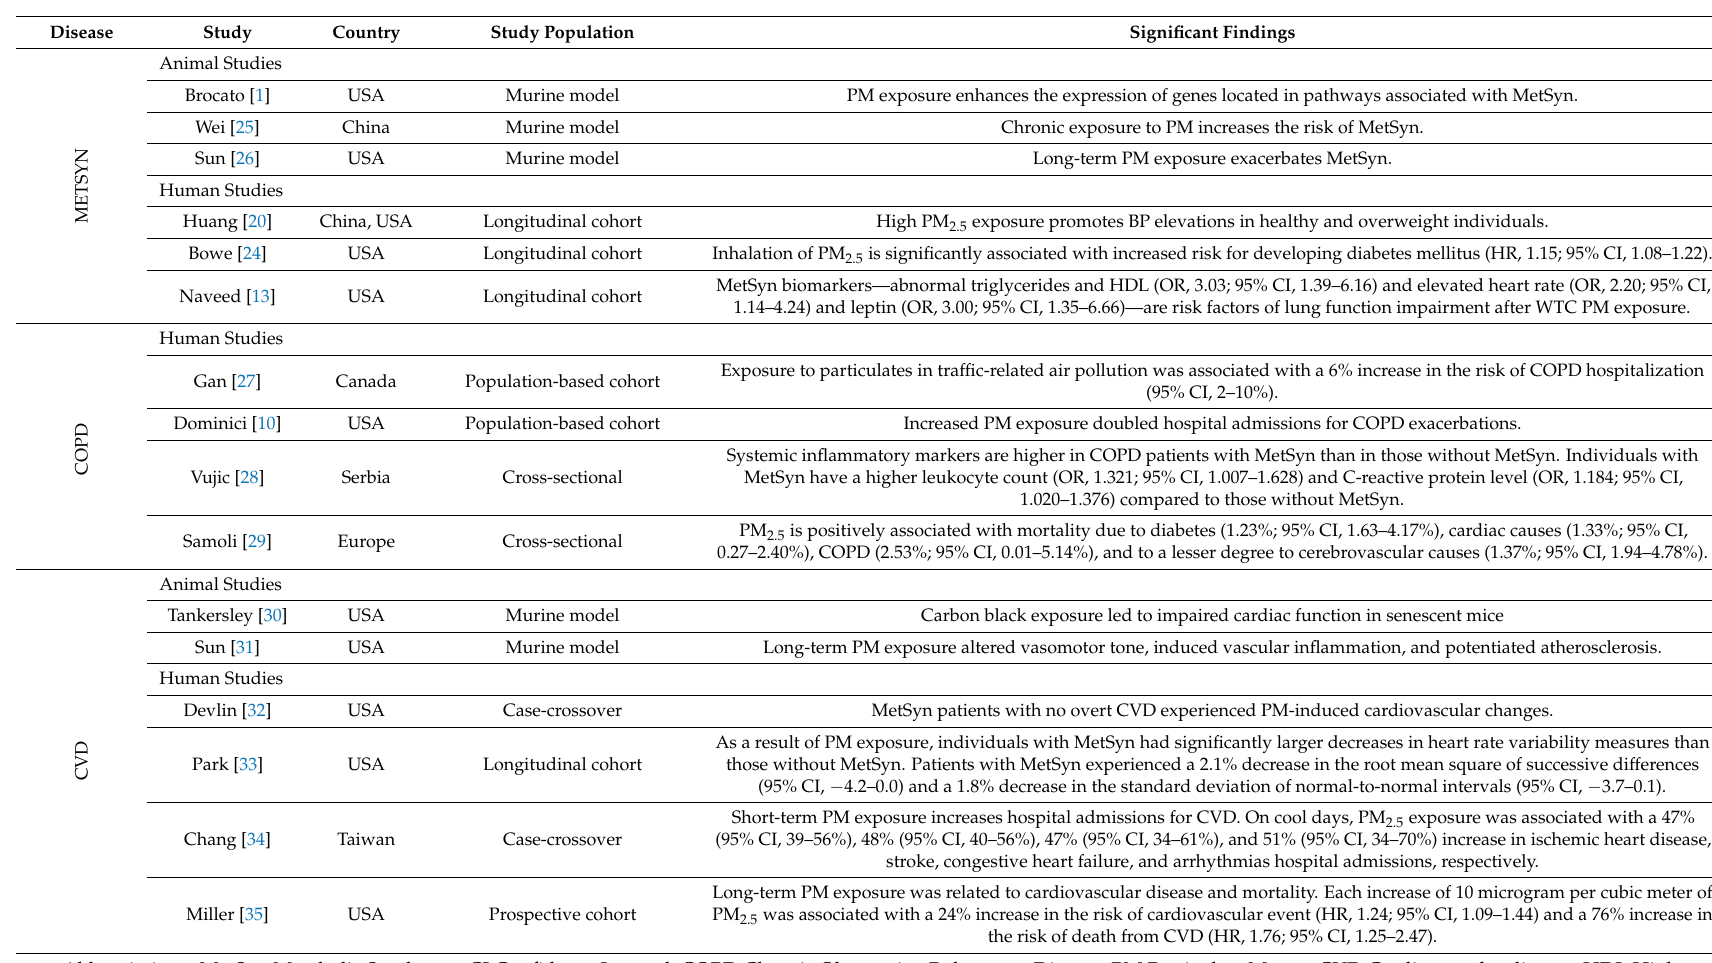
Table 1. Overview of the effects of PM exposure on metabolic and cardiopulmonary